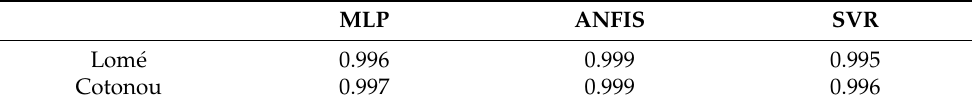
Table 9. Distribution area.